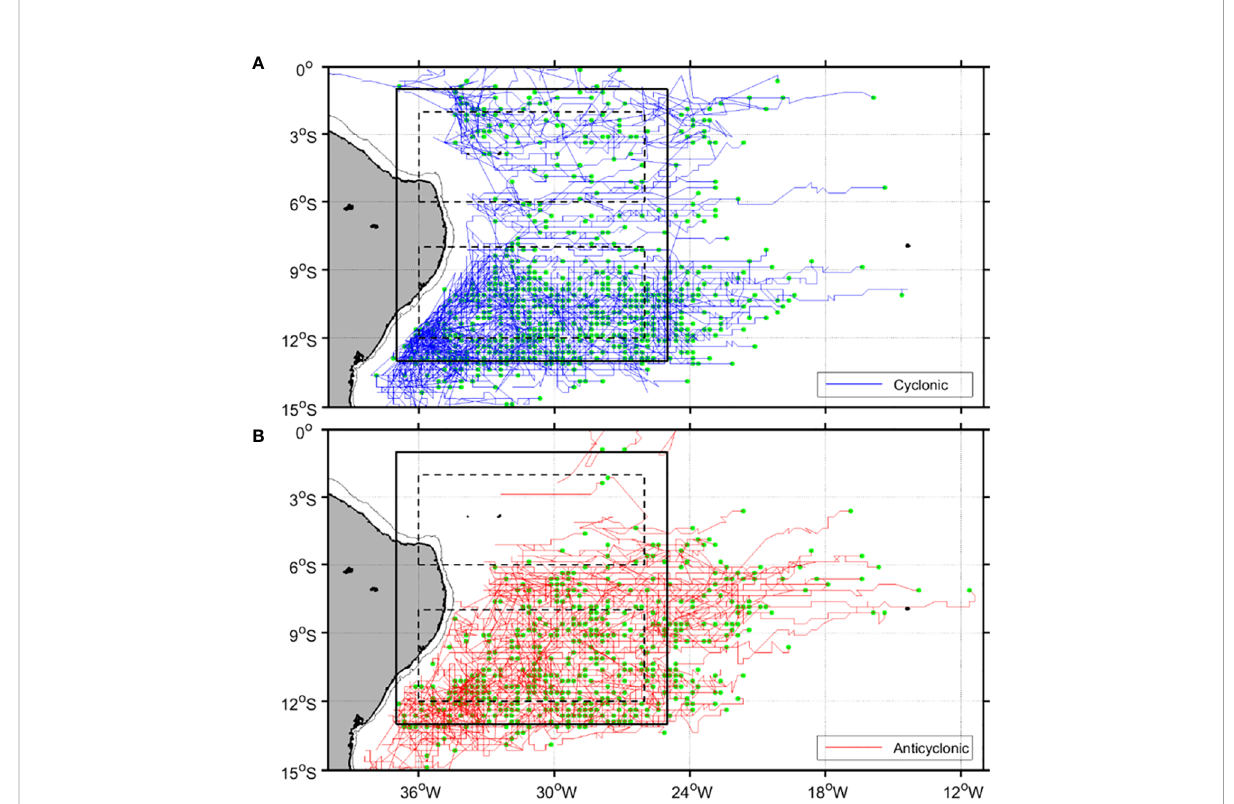
FIGURE 4 Trajectories of (A) cyclonic and (B) anticyclonic eddies which crossed the Northeast Brazil (NEB) region between January 1993 and December 2018. Green dots indicate the positions where these eddies were fi rst identi fi ed. Black boxes indicate the NEB region while dashed boxes show regions (A, B) as in Figure 3.